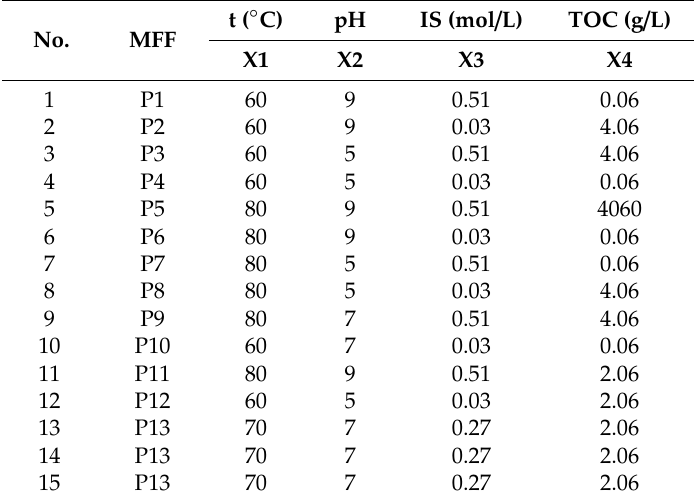
Table 2. Parameters of “model fracturing fluids” (MFF) for leaching tests of shale